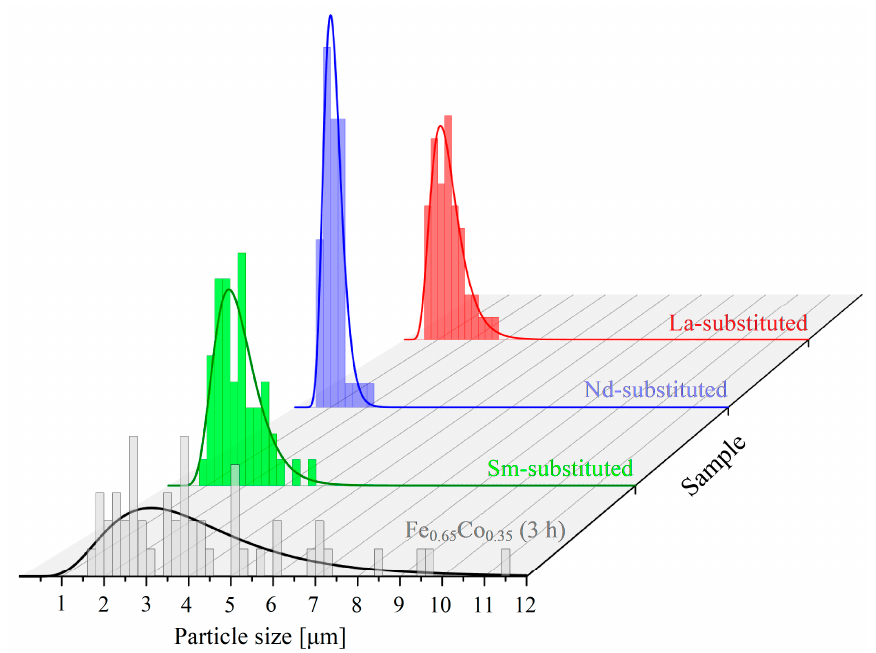
Figure 2. Average particle size distribution of Fe 0.65 Co 0.35 and (Fe 0.65 Co 0.35 ) 0.95 ( RE 2 O 3 ) 0.05 ( RE = La, Nd, and Sm) formed during effective high-energy ball milling for 3 h.